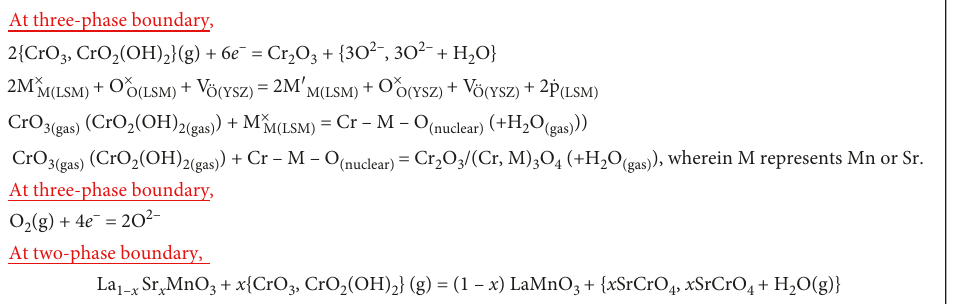
Figure 8: Typical reactions that may take place at an LSM cathode from Cr poisoning.